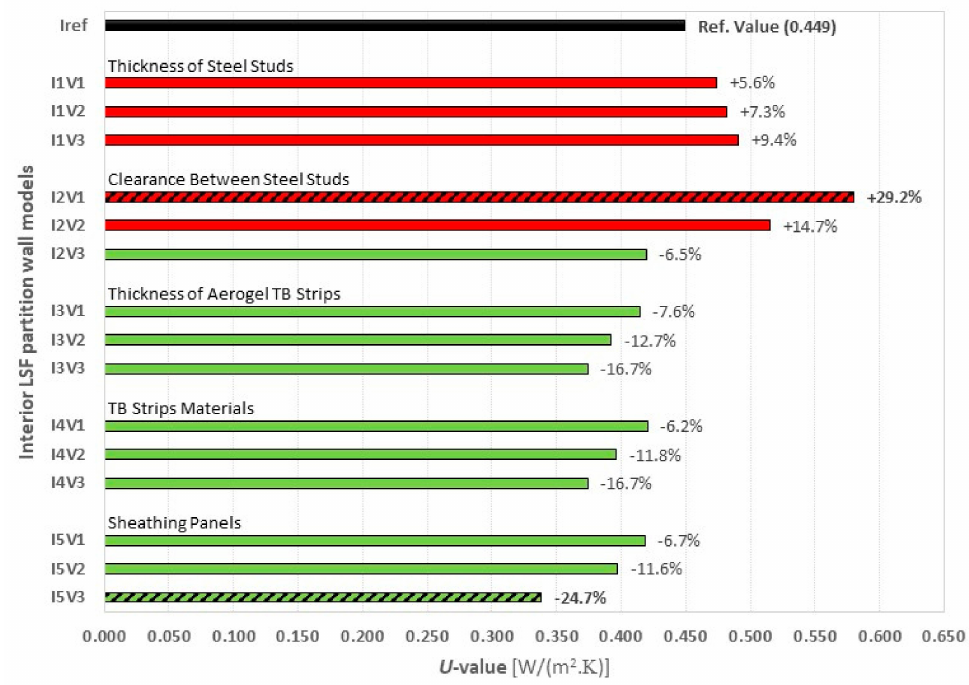
Figure 7. Thermal transmittances obtained for interior LSF partition